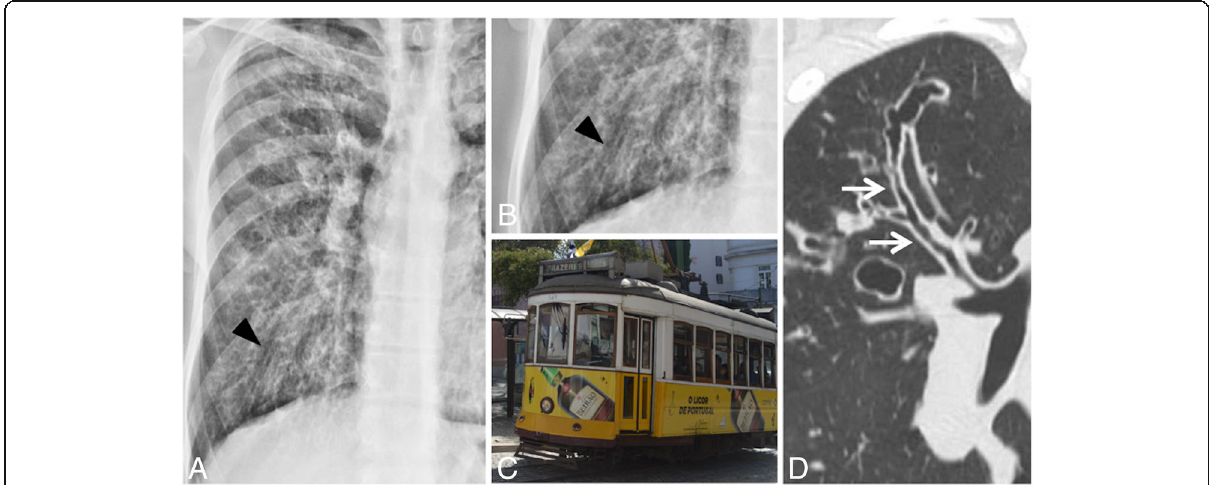
Fig. 34 Tram track sign. The tram track sign may be explained by the presence of thickened bronchial branches on radiographs (black arrowheads in a and b ), which reproduce a “ tram line ” appearance clearly shown on c . In d , the same appearance could be also described in a CT of a patient with cystic fibrosis: the coronal CT image shows thickened bronchial branches (cylindrical